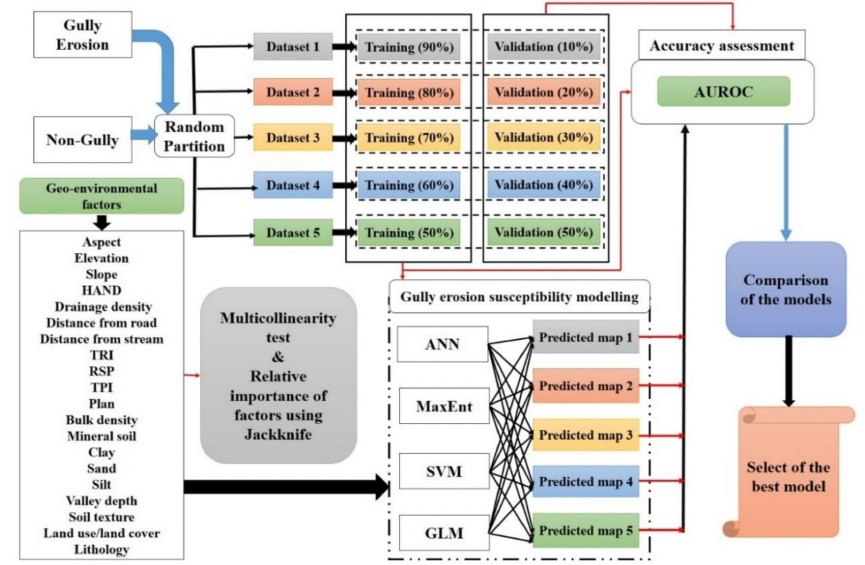
Figure 2. Flowchart of research in the study